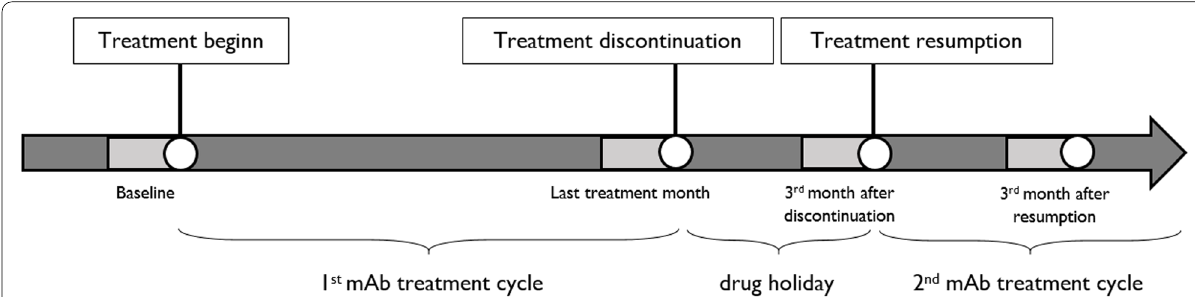
Fig. 1 Study timeline. The periods marked in light grey correspond to the study observation periods